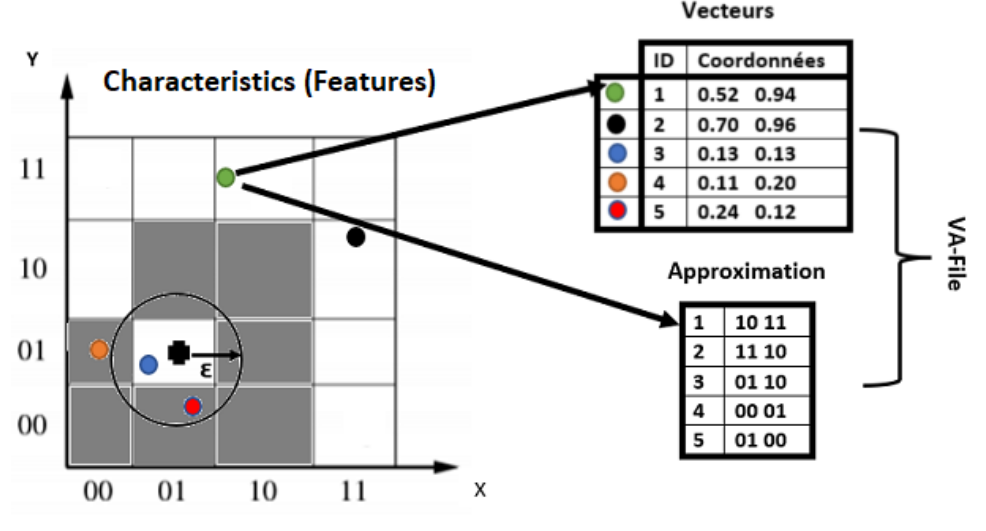
Figure 3. The research phase with